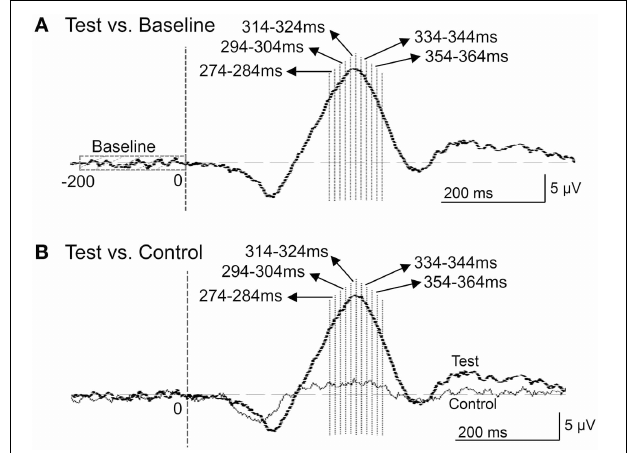
FIGURE 9 | Five 10-ms time windows for sLORETA analyses in the comparison between the baseline and ERPs in the test phase (A) and the comparison between the control and test phases